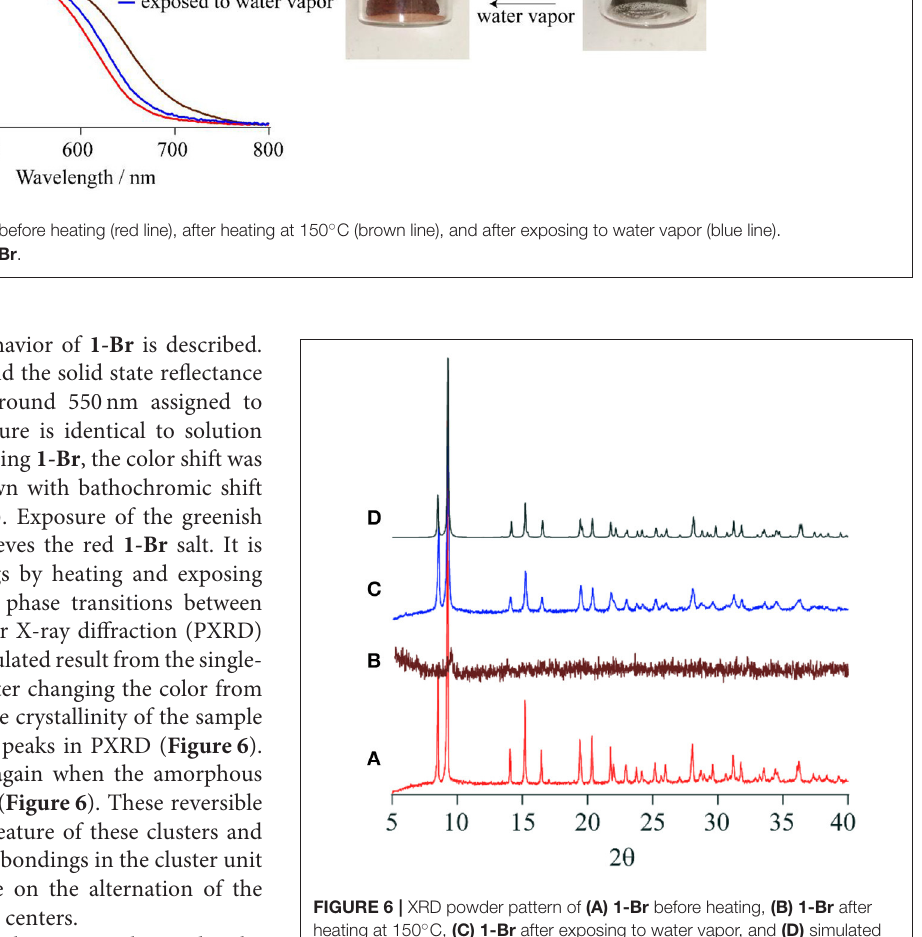
FIGURE 6 | XRD powder pattern of (A) 1-Br before heating, (B) 1-Br after heating at 150 ◦ C, (C) 1-Br after exposing to water vapor, and (D) simulated from the SC-XRD result of 1-Br